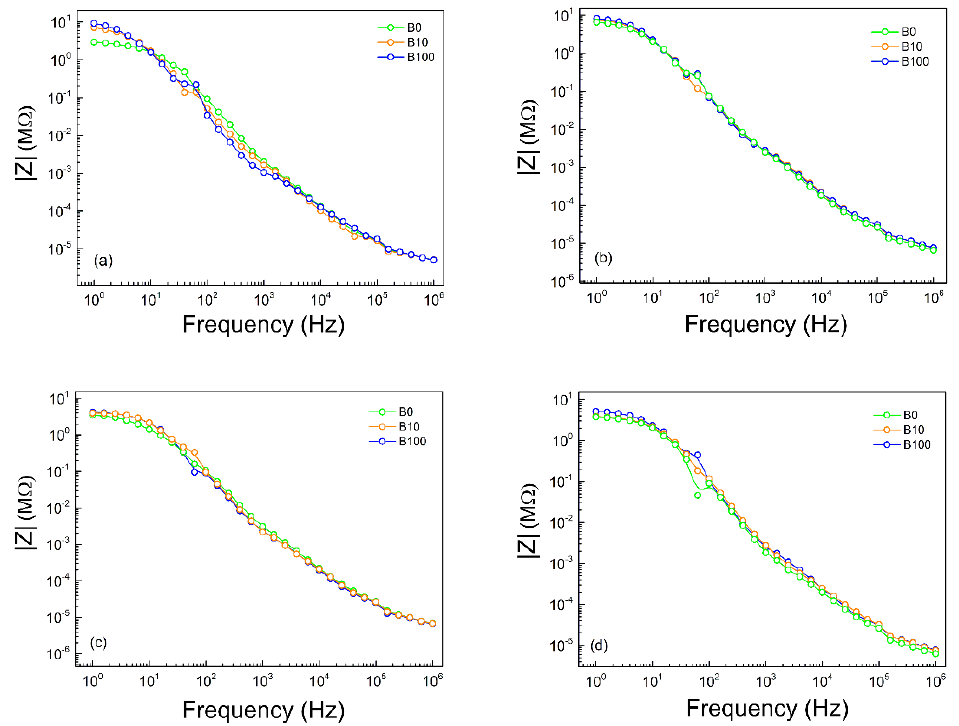
Figure 12. Bode diagram of the fuel samples, using the electrodes: ( a ) Ba1810, ( b ) Ba1820, ( c ) Ba1830 and ( d ) Ba1850.